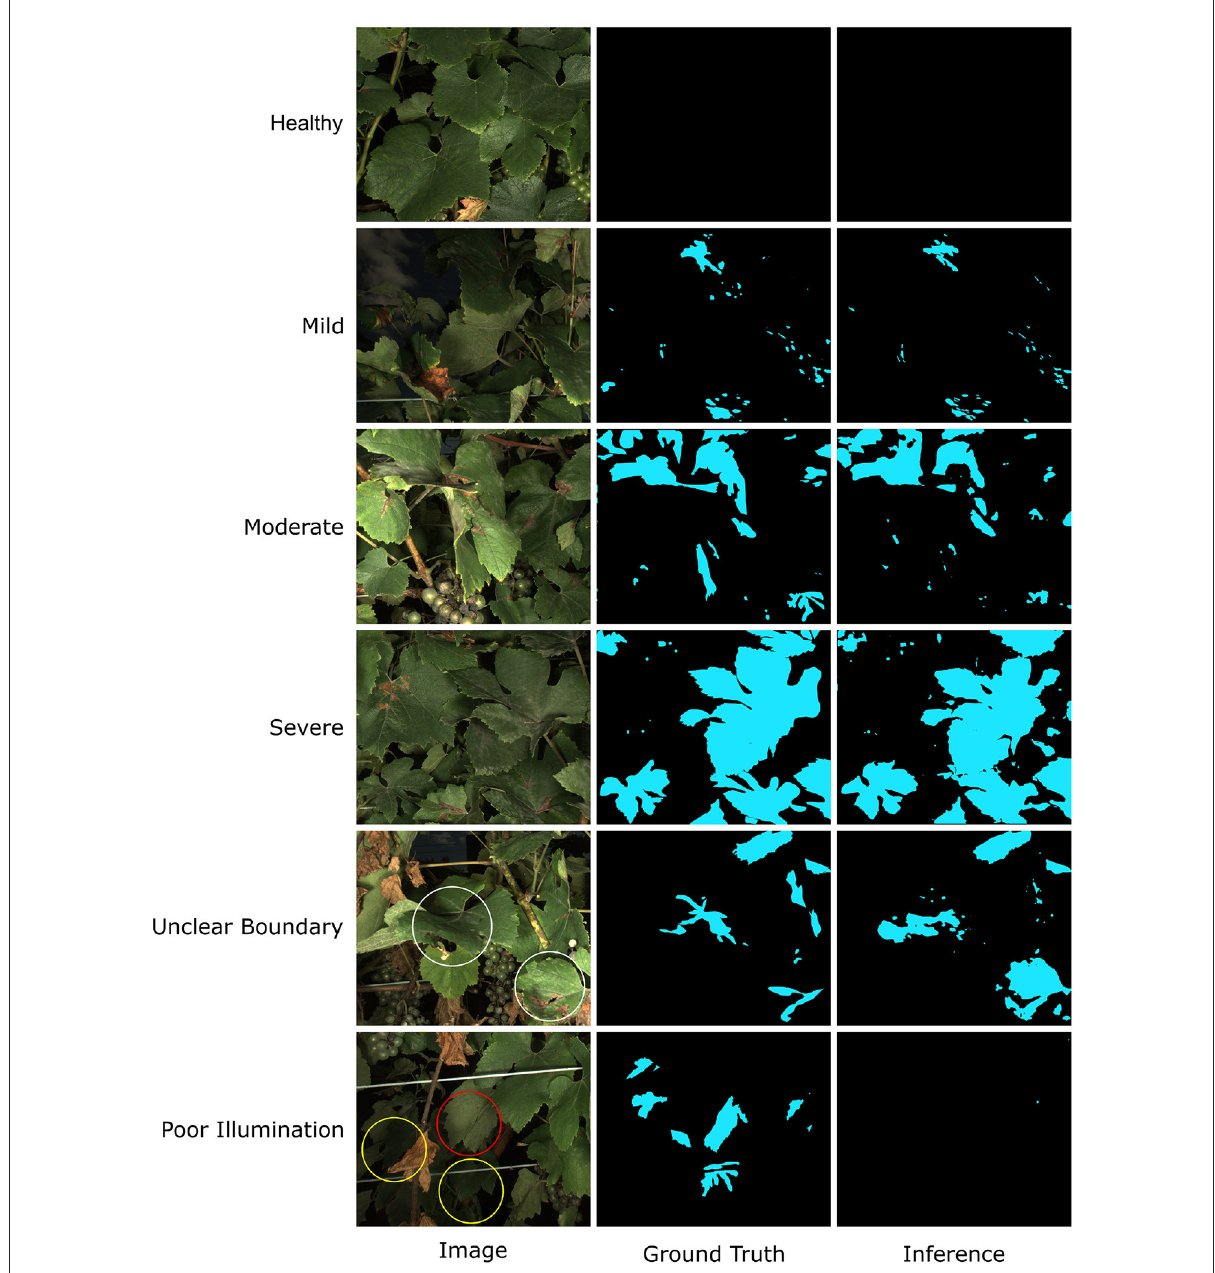
FIGURE11 Examples of Powdery Mildew (PM) infection segmentation mask generated by HMASS. Images are selected from testing dataset. Ground truth are manually labeled. White circles are regions where boundaries of infections are not correctly detected. Yellow circles are false negative detections due to insufficient lighting condition. Red circles are false negative detection due to variant unobvious appearance of PM